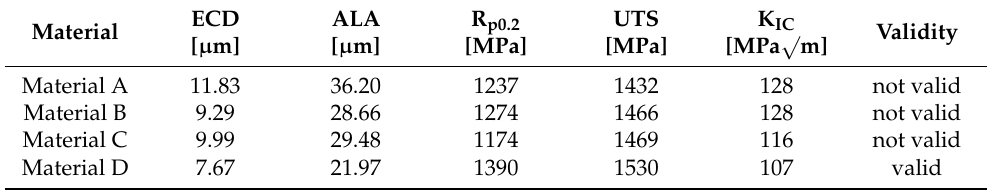
Table 1. Microstructural constituents and mechanical properties from all tested